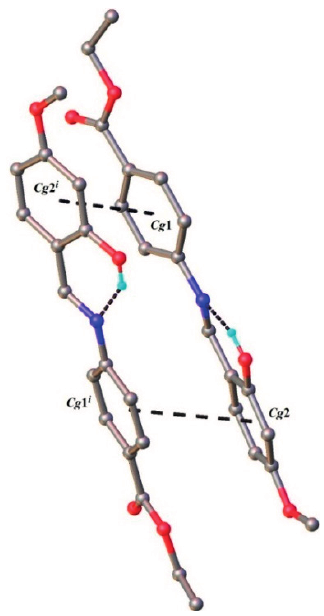
Figure 4. π - π staking interactions in the crystal structure ( HL ).